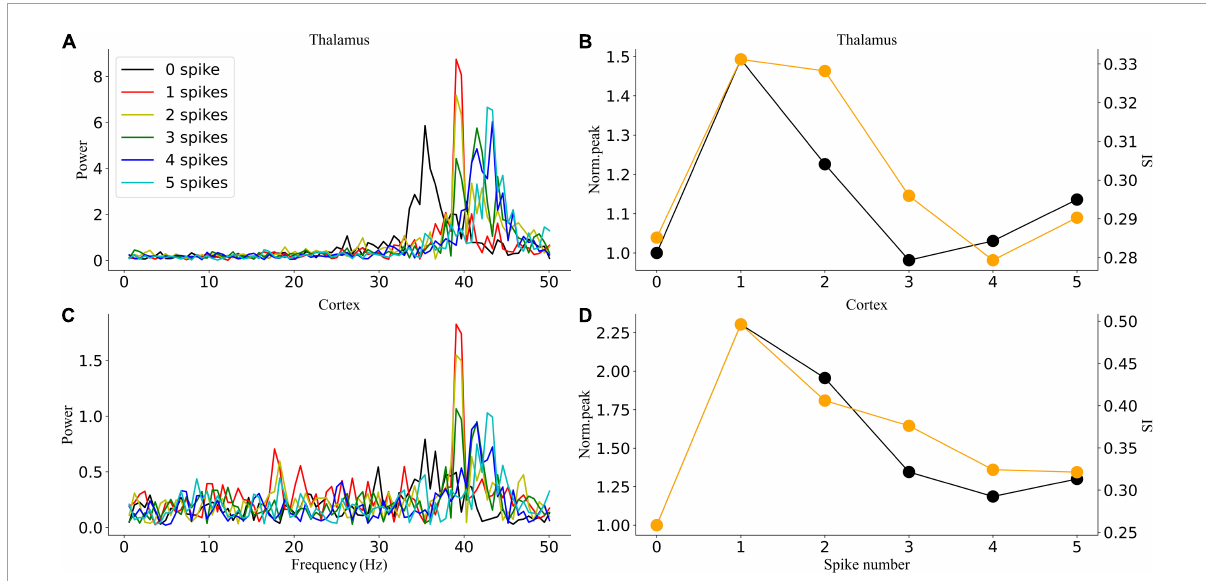
FIGURE8 Oscillatory dynamics modulated by 40-Hz flicker with different duty cycles. (A) The sLFP spectrum of the thalamus. (B) The peak power and SI of the thalamus. (C) The sLFP spectrum of the cortex. (D) The peak power and SI of the cortex.